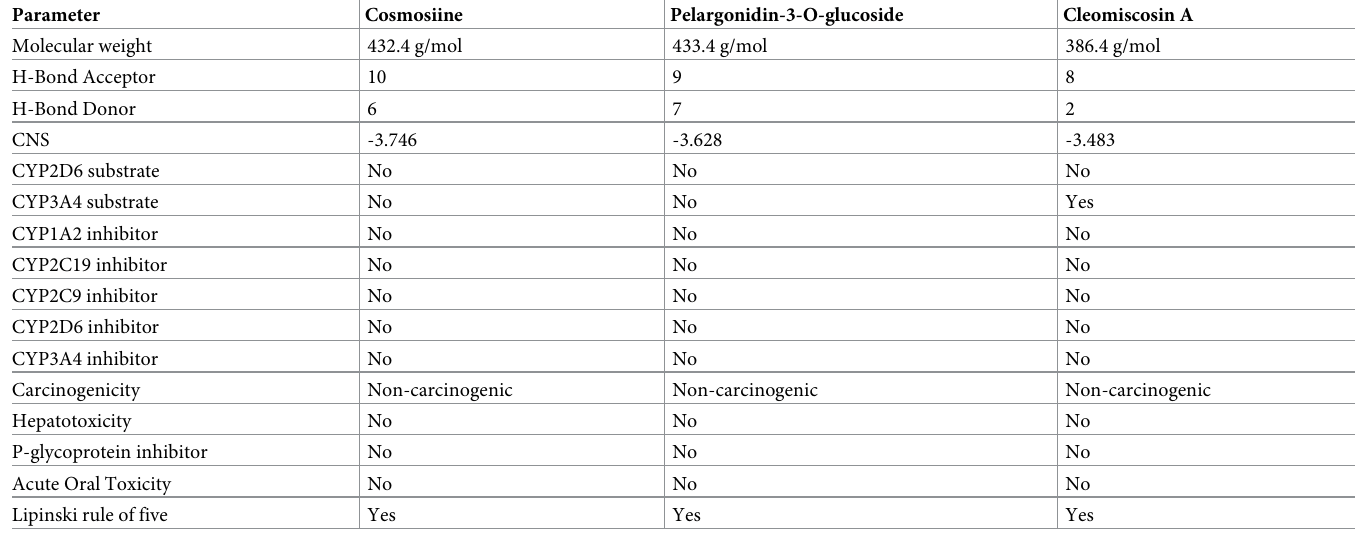
Table 2. Pharmacological profile of the top three potential candidates derived from SwissADME, admetSAR, and pKCSM webservers.